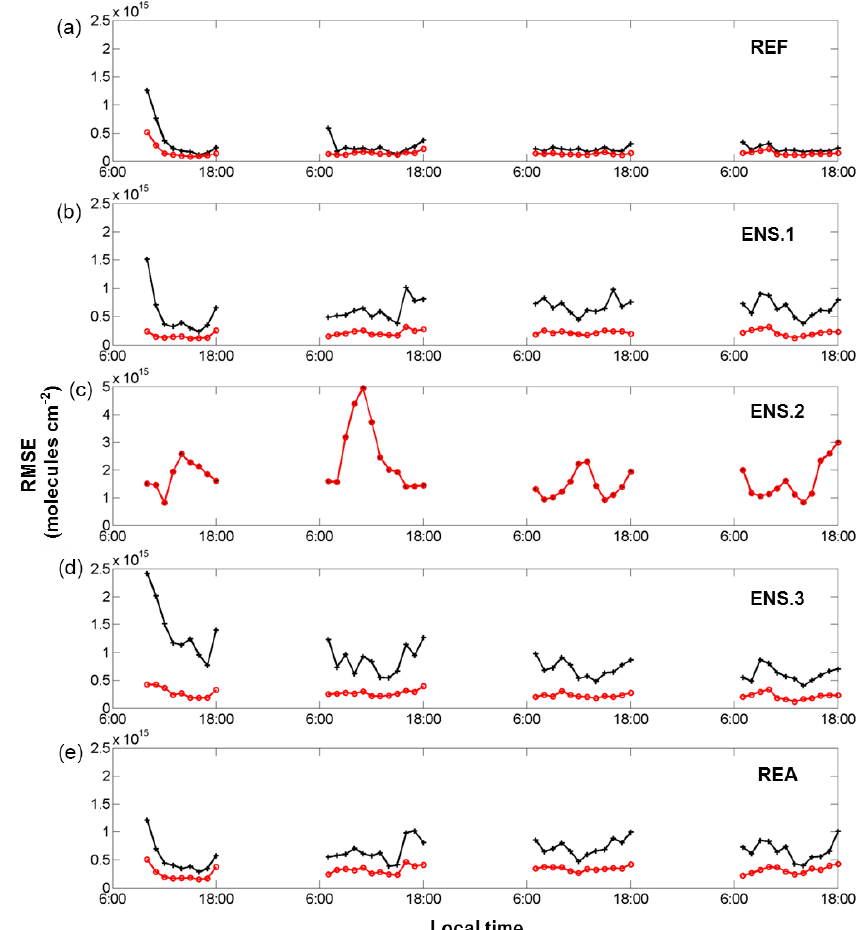
Figure 4. Time evolution of prior (black) and posterior (red) RMSEs of Denver TEMPO NO 2 column observation from 2 July 10:00 to 5 July 18:00 for REF, ENS.1, ENS.2, ENS.3, and REA (from a to e ).